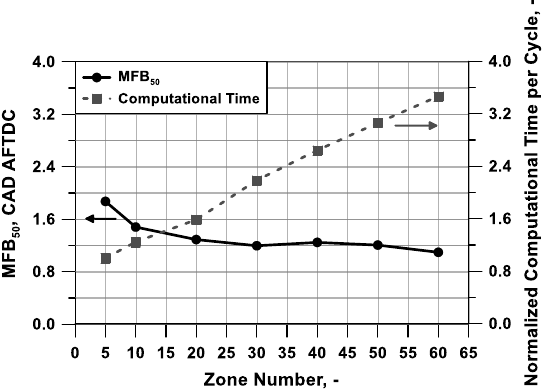
Figure 9. MFB 50 and normalized computational time per cycle against the zone number.